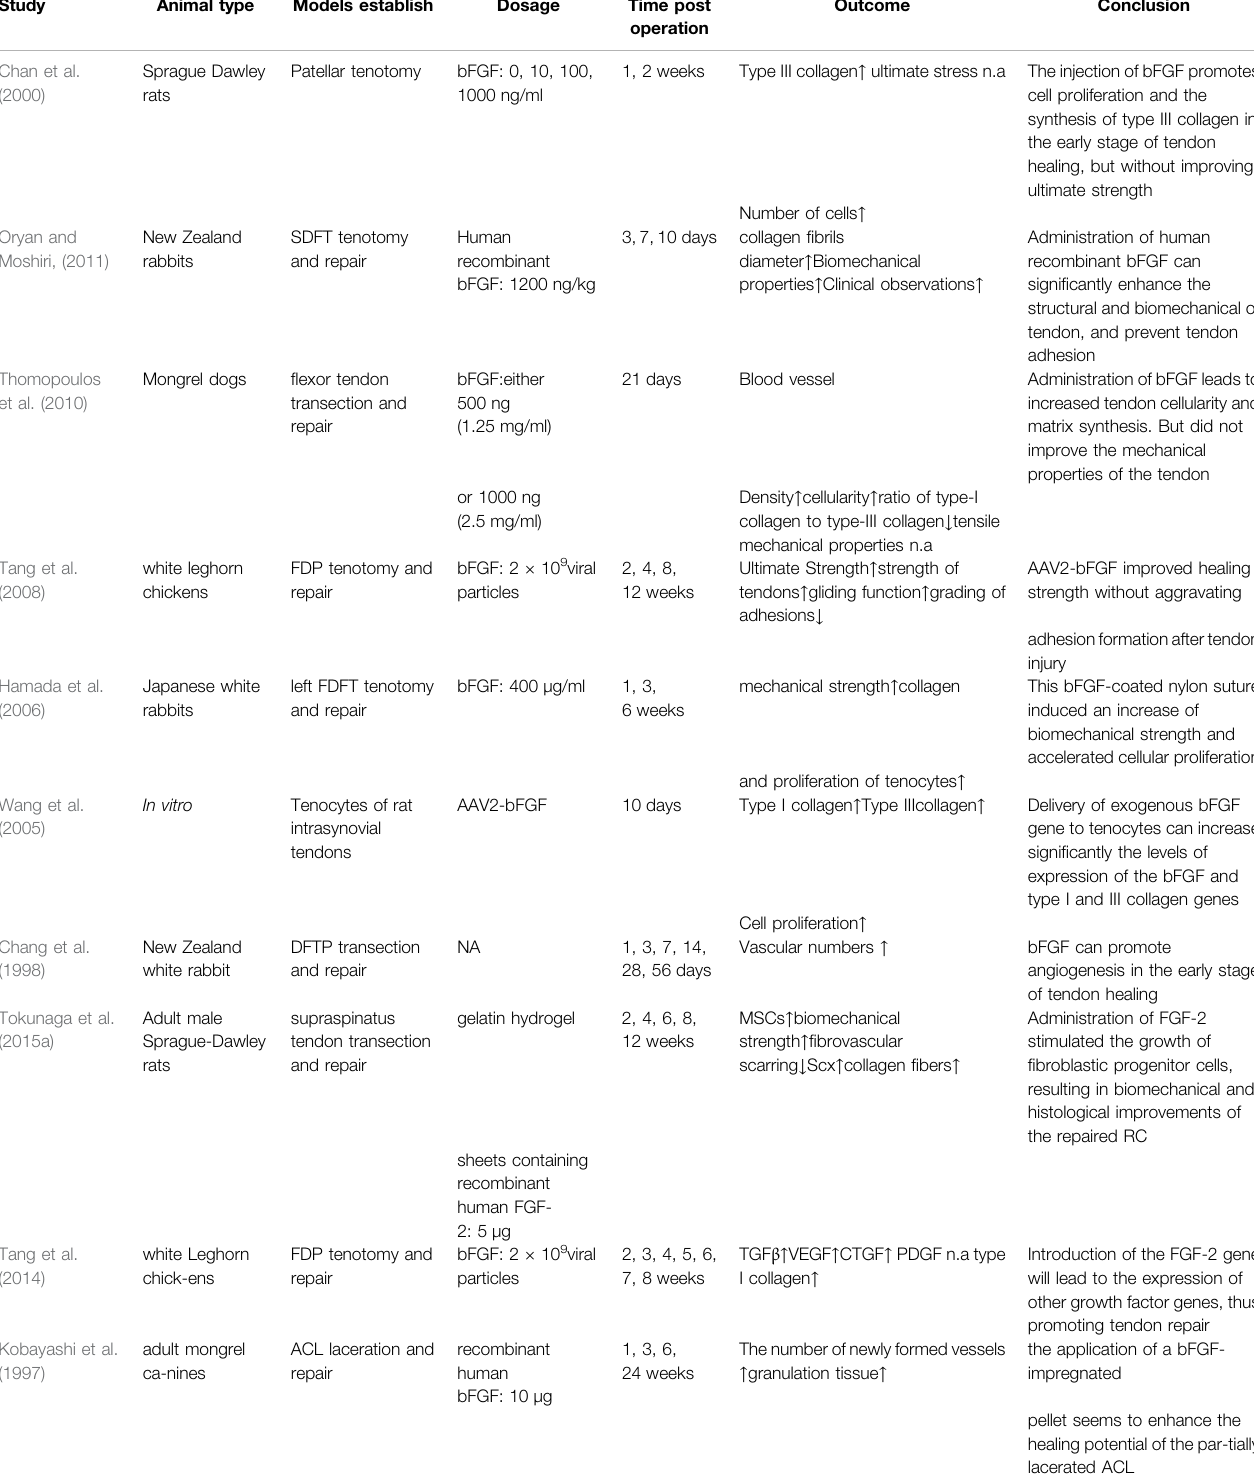
TABLE 1 | Summary of results and characteristics of the studies which investigated the effects of bFGF in tendon